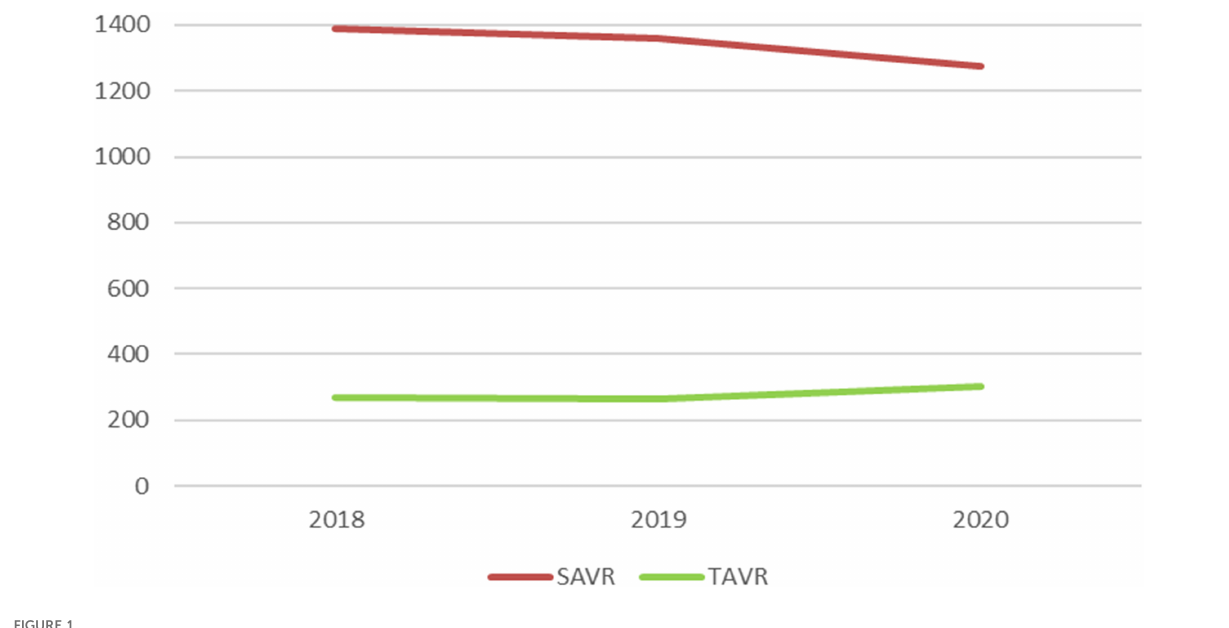
FIGURE 1 Numbers of SAVR and TAVR for pure aortic regurgitation between 2018 and 2020 in Germany. SAVR, surgical aortic valve replacement; TAVR, transcatheter aortic valve